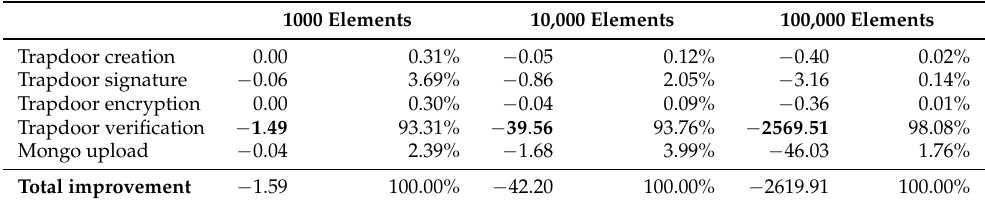
Table 4. Shared index update process duration with cache—variation in results compared with no cache (in seconds and percentages).